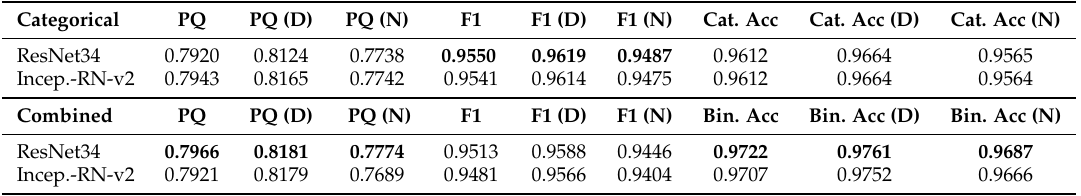
Table 3. Detection results for the ellipses extracted with categorical segmentation and the combined segmentation: Regardless of the selected backbone, detection rates of about 95% (F1 score) are achieved. For detailed information about precision and recall, see Table 8. It is noticeable that, with the combined segmentation approach, the accuracy of the binary segmentation remains unaffected, although the segmentation head and the pixel-embedding head jointly influence the weights in the